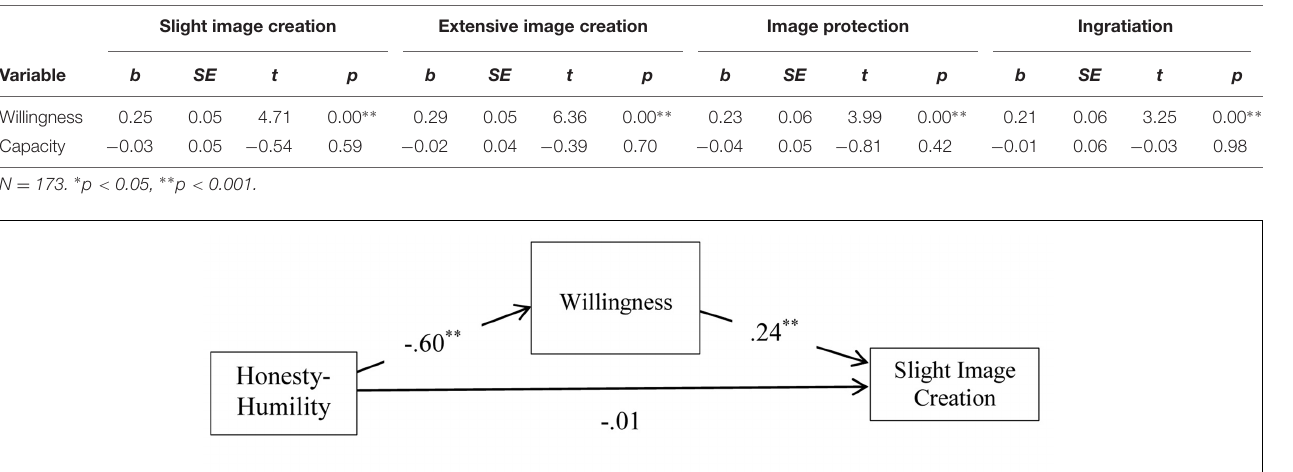
TABLE 4 | Multiple regression of IM, willingness, and capacity.